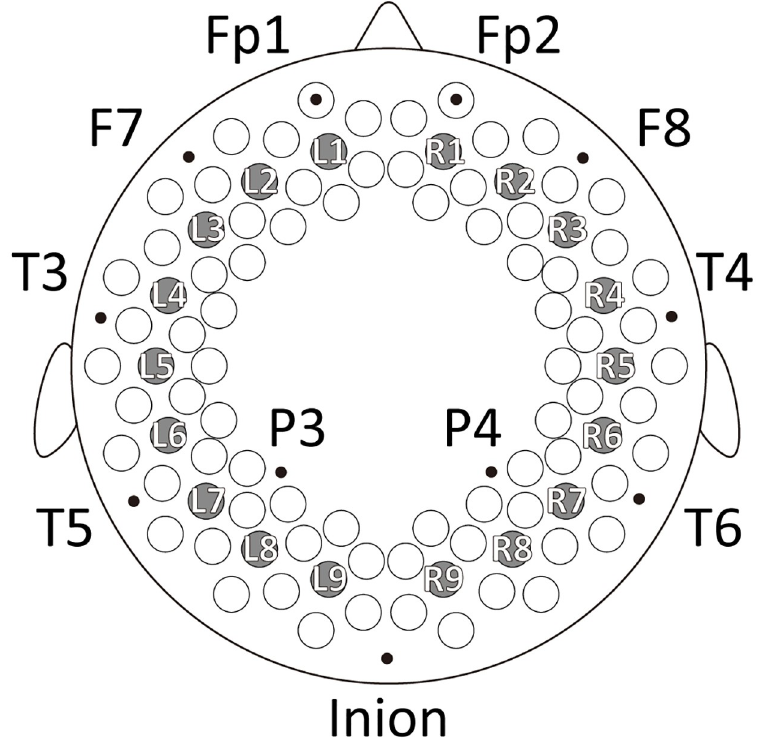
Fig 4. Arrangement of fNIRS measurement channels. Circles indicate 94 measurement channels. Eighteen circles filled in gray (L1 to L9 and R1 to R9) show the channels used in the present analysis. For reference, some landmarks (black dots) of the international 10/20 system are